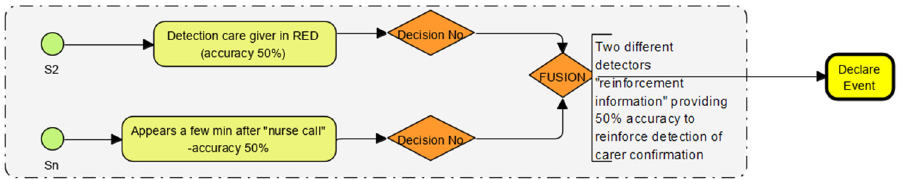
Figure 5. Using colour information to “reinforce” the arrival of a “nurse” in red clothing just after a “nurse-call” trigger is initiated. (sensor data in green detected but not accurate enough at decision point in mauve diamond. However at a fusion decision point in mauve diamond they reinforce and confirm the event in